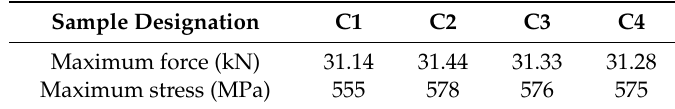
Table 3. Maximum force and stress values recorded for samples subjected to high DC voltage and temperature—group C.